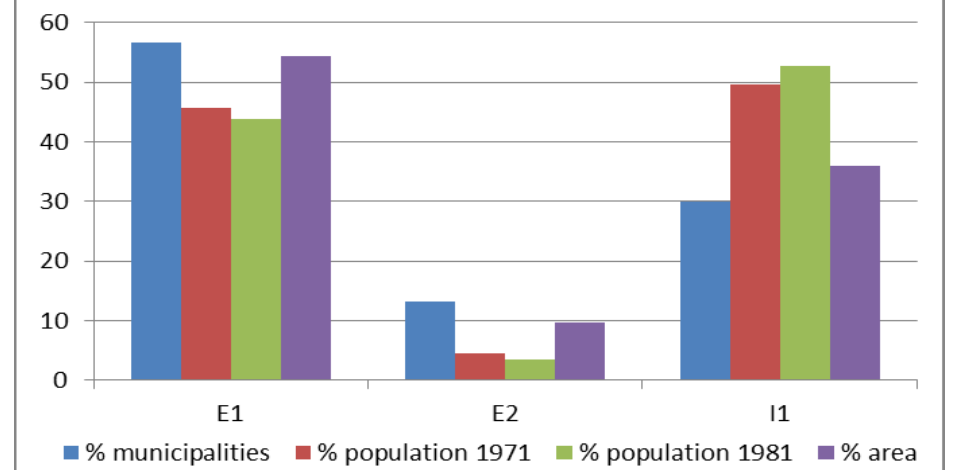
Fig. 1. Distribution of municipalities, population and area according to migration intensity in the period 1971-1981 (data calculated by the authors, according SSORM data)